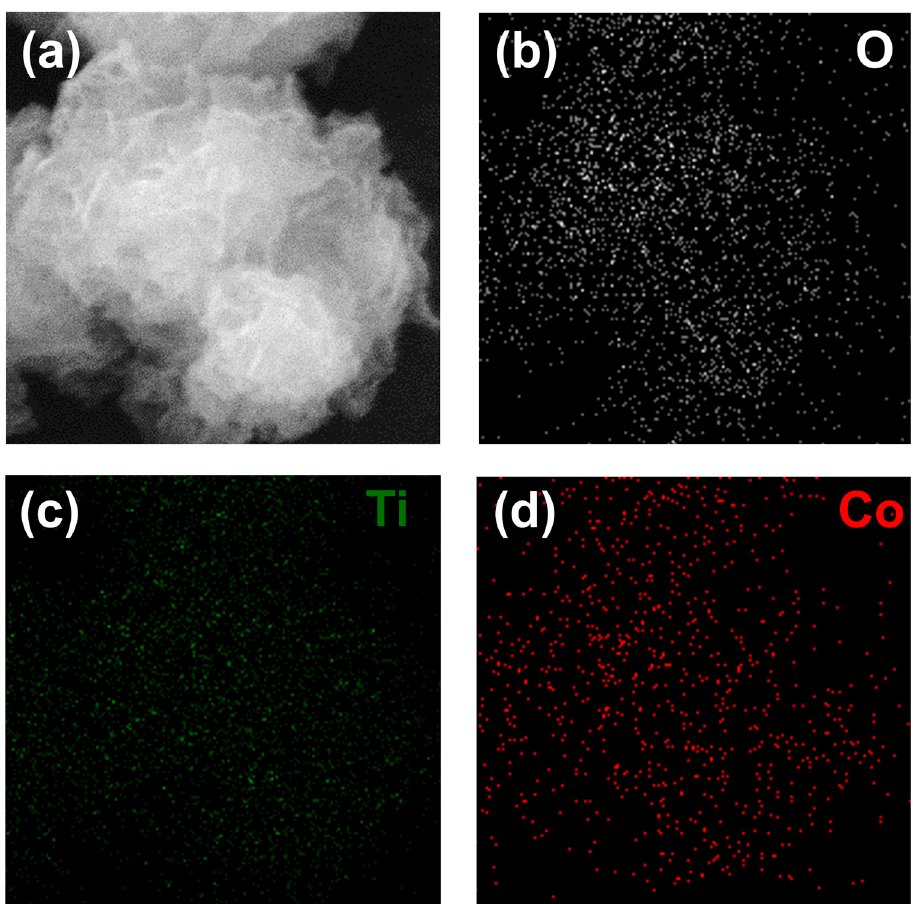
Figure 2. ( a ) Scanned region of CTO; ( b – d ) elemental mapping analyses of CTO.